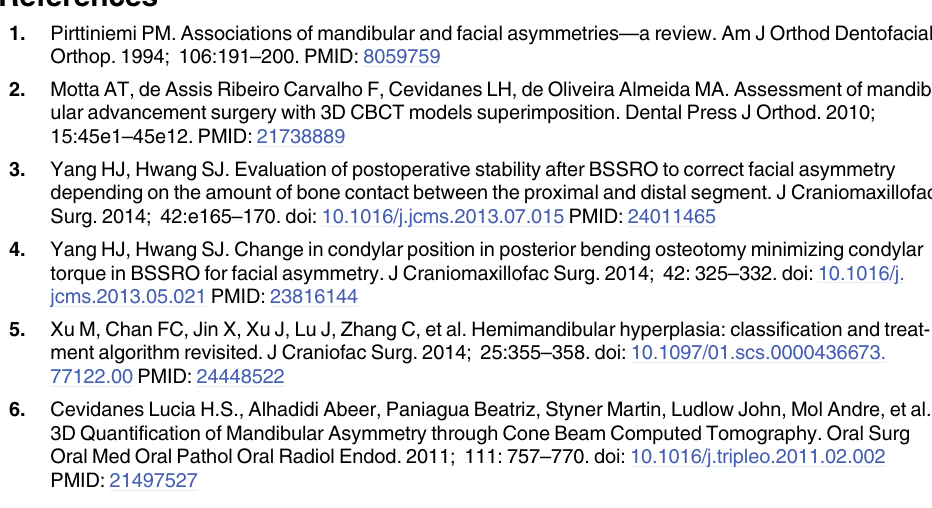
S2 Fig. Example of a typical case for evaluation method verification. (a) Three dimensional model with pre-surgical orthodontic treatment (before virtual BSSRO surgery); (b) Three dimensional model after virtual BSSRO surgery; (c) Three dimensional post-surgical model. The volumetric differences between both sides of hemi-mandible were calculated to verify the outcome consistency between surgery and virtual surgery. (TIF) S1 Table. The mean values of clinical examination after virtual Me point correction and after clinical orthognathic surgery.